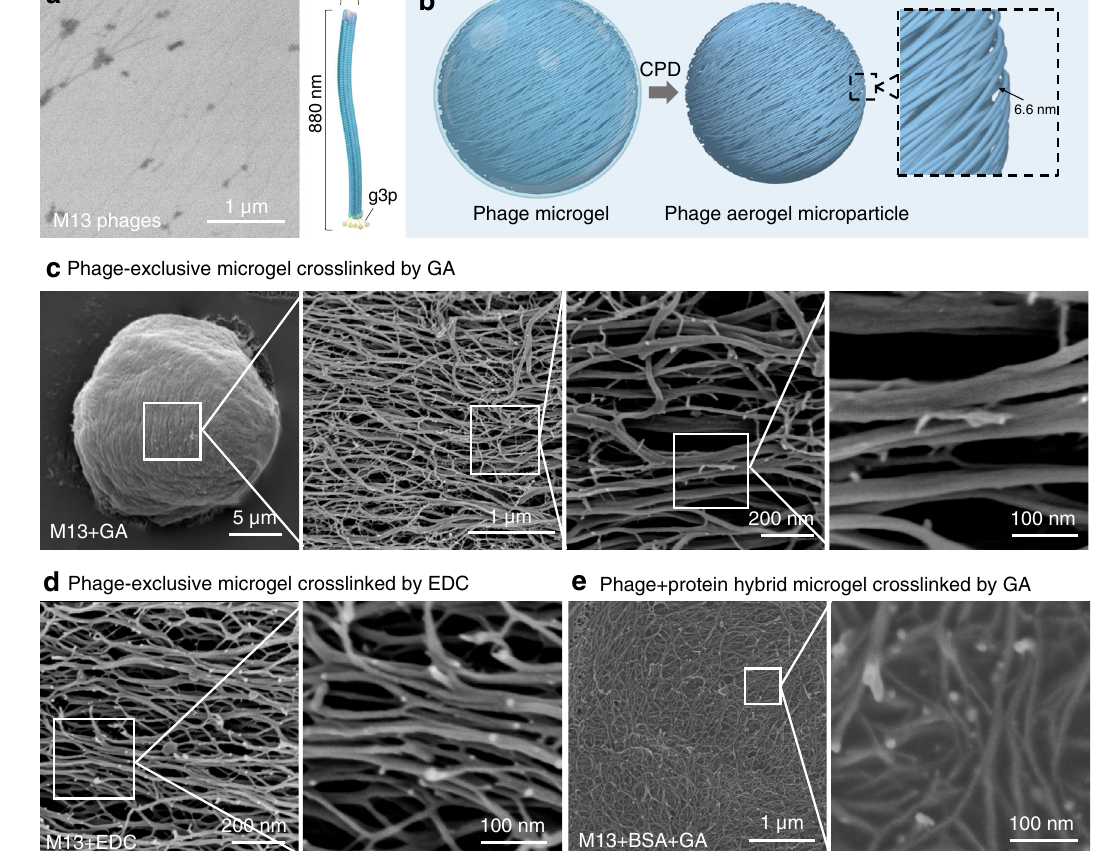
Fig. 2 | Aligned nano fi brous texture of phage microgels. a SEM image of non- crosslinked M13 phage nano fi bers and schematic image of a nano fi lamentous M13 phage showing high aspect ratio. b Schematic image of a hydrated phage microgelcomposedofcrosslinked fi lamentousM13phagesturningintoaphage aerogel microparticle by critical point drying (CPD), showing a nano fi brous texture. c SEMimagesofaM13phage microgelcrosslinkedby GAandthehighly